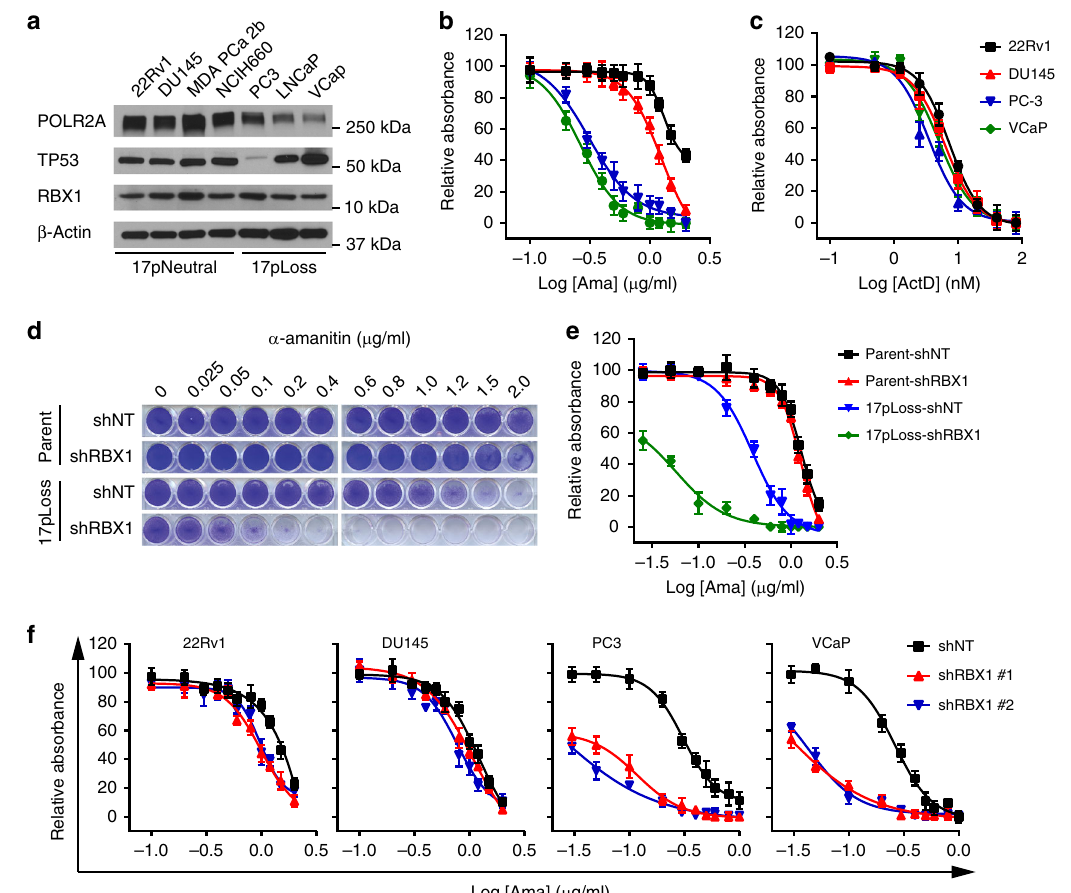
Fig. 7 RBX1 depletion sensitized 17p loss prostate cancer cells to POLR2A inhibition. a Protein levels of POLR2A, p53, Rbx1, and β -Actin in human prostate cancer cell lines. b , c Cell proliferation of 17p neutral (22Rv1 and DU145) and 17p loss cells (PC3 and VCaP) treated with α -amanitin ( b ) or actinomycin D ( c ). d , e RBX1 depletion sensitizes the 17p loss DU145 cells to the treatment of the POLR2A inhibitor, α -amanitin. Representative images ( d ) and quantitative results ( e ) of cell survival are shown. f Cell proliferation of human prostate cancer cell lines under α -amanitin treatment. 17p neutral (22Rv1 and DU145) and 17p loss (PC3 and VCaP) cells, with or without Dox-induced RBX1 knockdown, were treated with increasing doses of α -amanitin. Data are representative